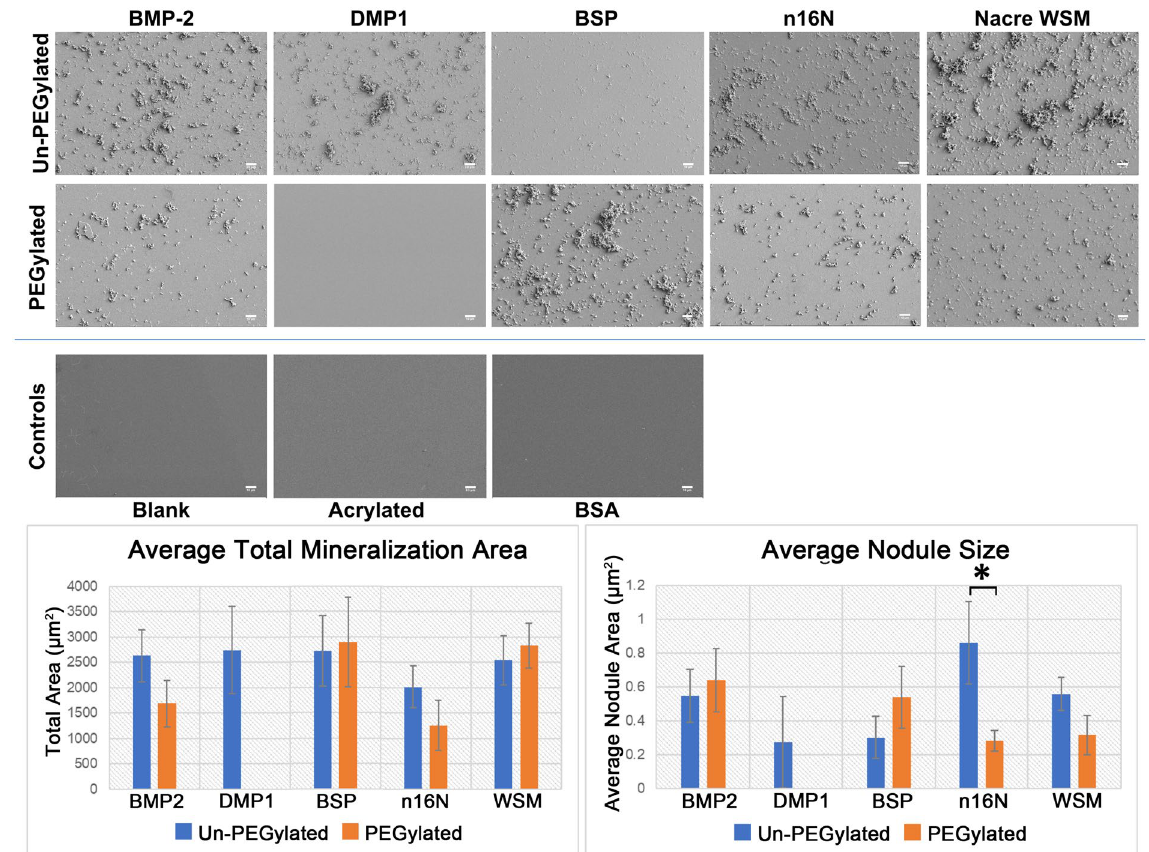
Figure 2. FE-SEM images of glass slides coated in PEGylated and non-PEGylated proteins or peptides following mineralization assays. Slides were acrylated and PEG-proteins were covalently bound or cleaned slides were adsorbed with un-PEGylated proteins. Controls, clean blank slides, acrylated slides, and slides with adsorbed BSA did not induce mineralization and are therefore featureless. Scale bars are 10 μm. Error bars show standard deviation. Asterisks denote significant difference between indicated samples ( p < 0.05). Note No mineralization was observed in PEGylated DMP1